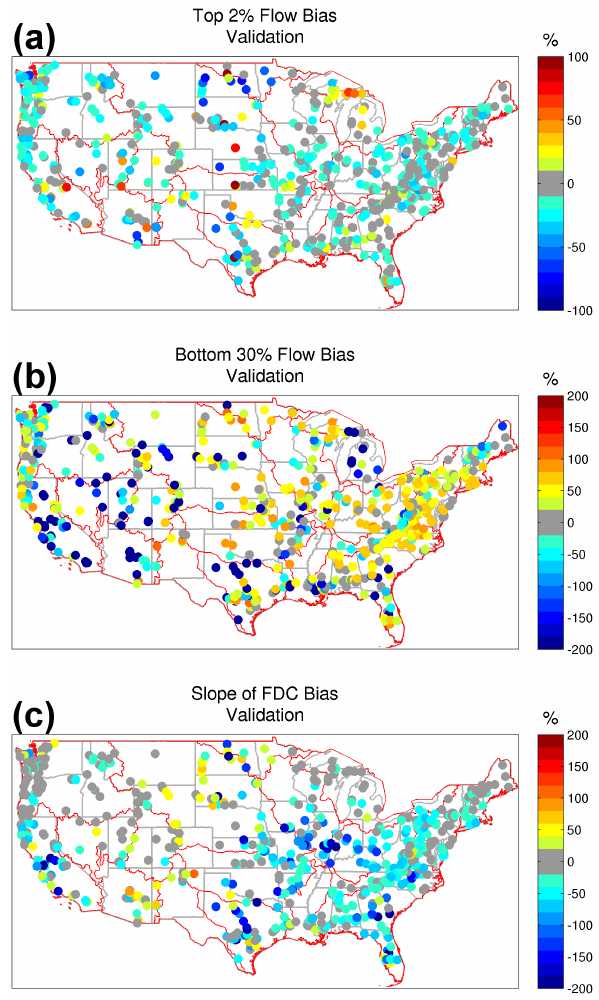
Figure 6. (a) Spatial distribution of the high flow bias, (b) low flow bias, and (c) flow duration curve bias for the validation period.